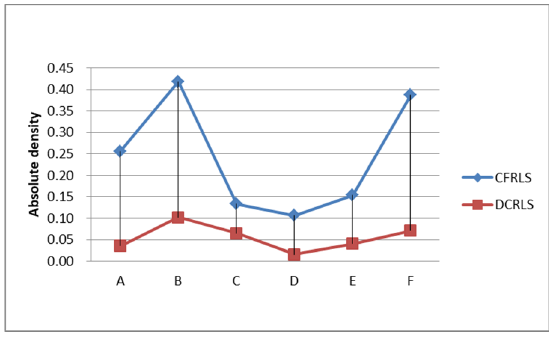
Figure 9. Comparison of absolute density.